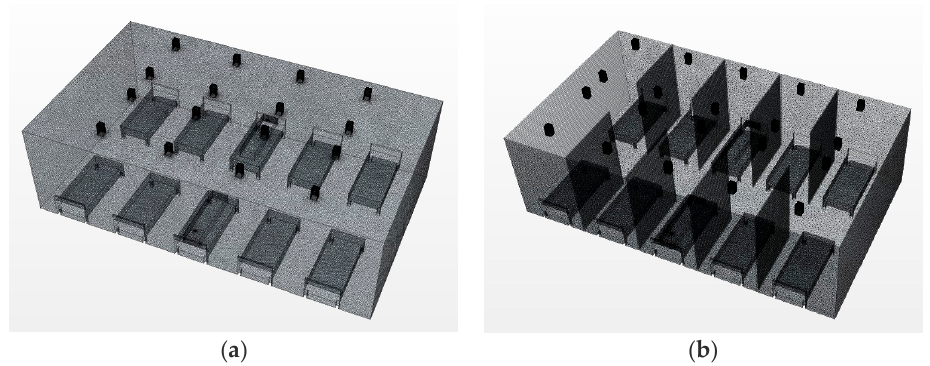
Figure 2. Geometric features of the simulation models and space meshing conditions. ( a ) Base model